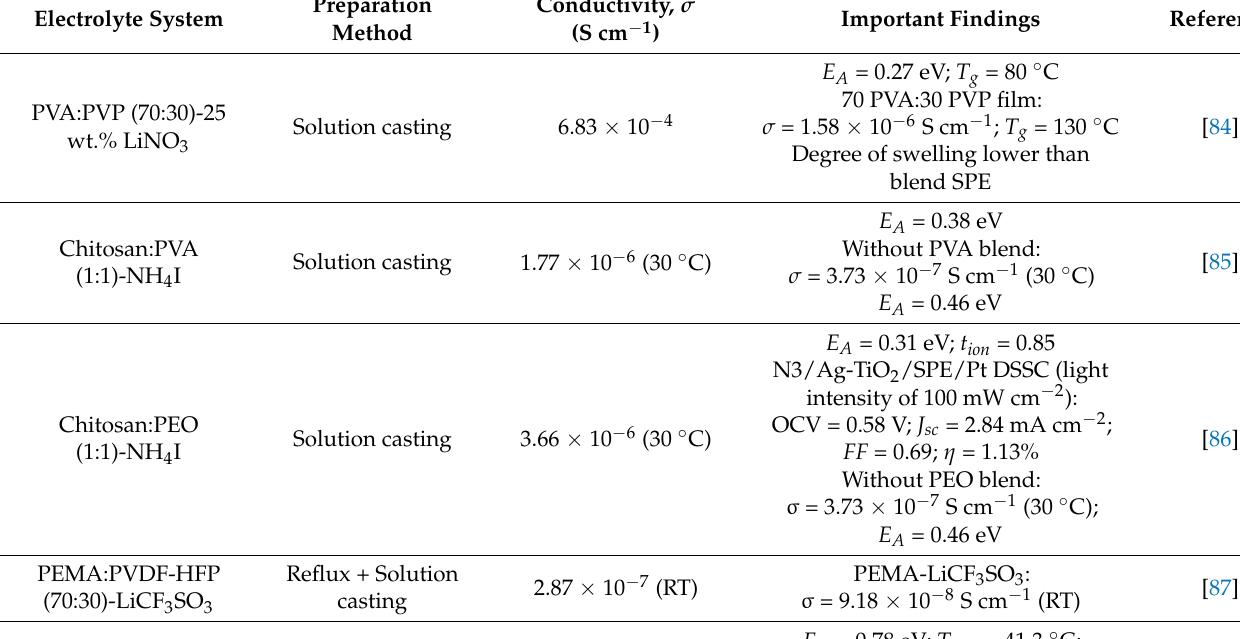
Table 5. Various blended SPEs systems, along with their conductivity values and other important parameters. Electrolyte